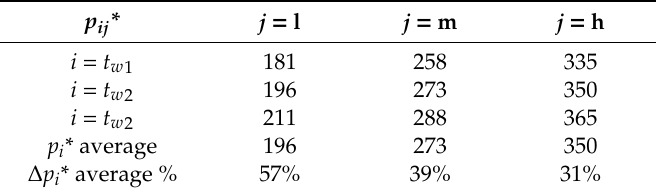
Table A10. Post-COVID dental charges for the nine mix typologies under consideration, the average dental charge for the three treatment typologies (l, m, h), based in working times ( p i * average) and their percentage variation, compared to the pre-COVID dental charges ( ∆ p i * average